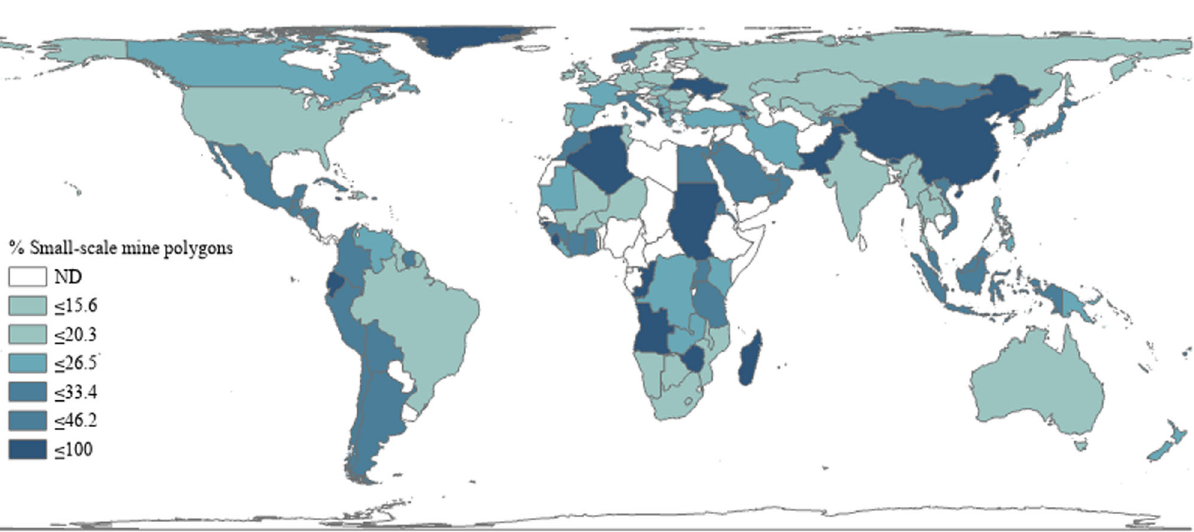
Fig. 4 Global distribution of small-scale mining polygons. Percentage of mine polygons <0.062 km 2 per country, signaling and validating an increased prevalence of